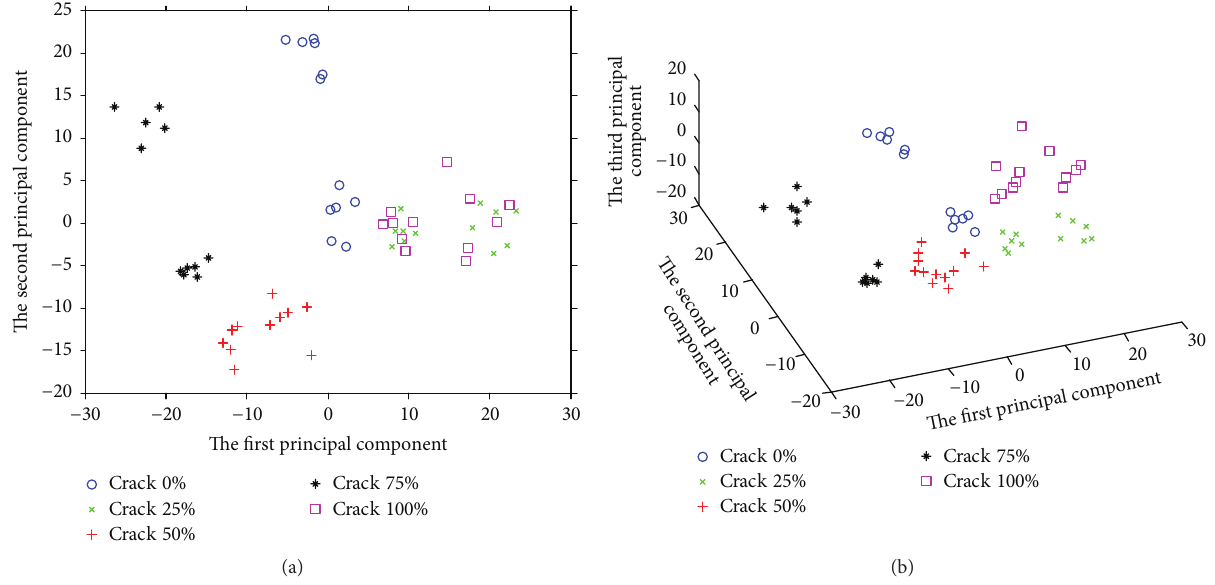
Figure 8: The principal components of the training data for experiment 2 : (a) the first two principal components; (b) the first three principal components.